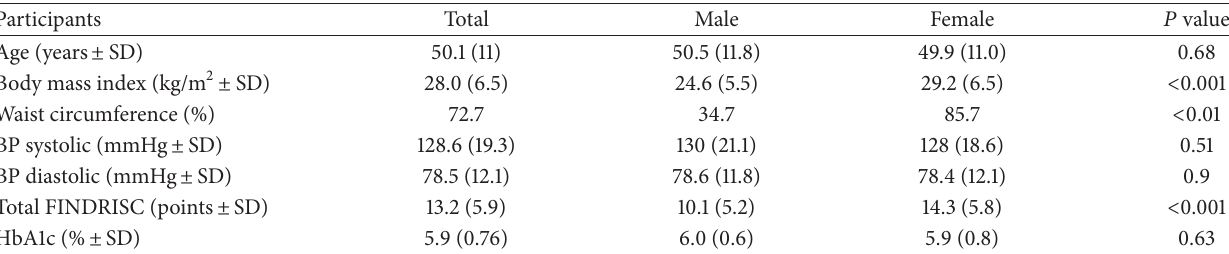
Table 1: General characteristics of the participants ( 𝑁 = 291 ).